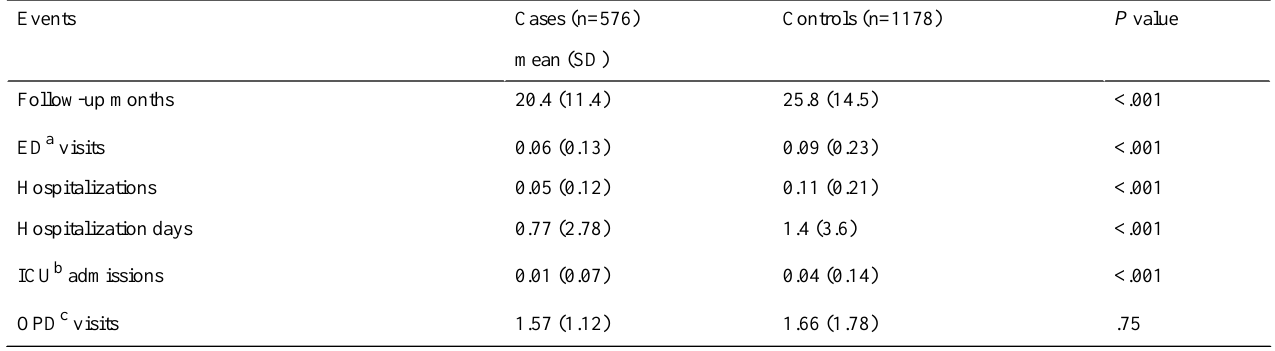
Table 2. Clinical events, adjusted by follow-up months.